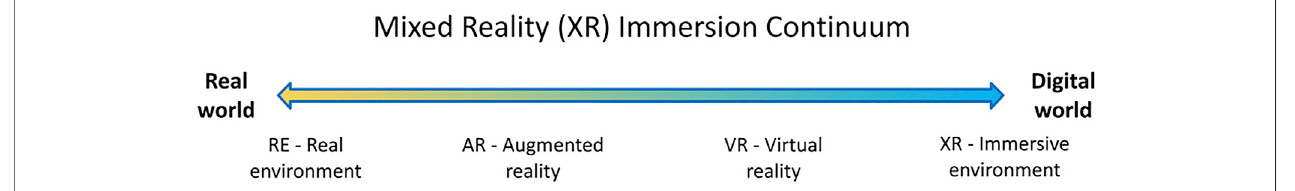
FIGURE 1 | The mixed reality (XR) immersive digital continuum (adapted from Milgram and Kishino,